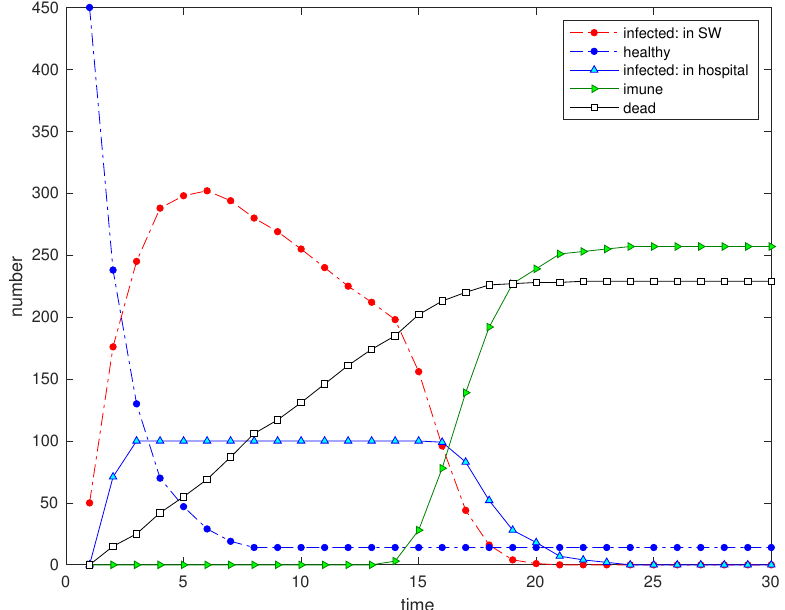
Figure 4. Scenario S 3 : Time evolution of the 5 state variables for N h = 100 ( N = 500, n i = 50, D = 0.07, δ = 0.1, p 1 = 0.1, p 2 = 0.9, p 3 = 0.7, p 4 = 0.05, p 5 = 0.02 and α =